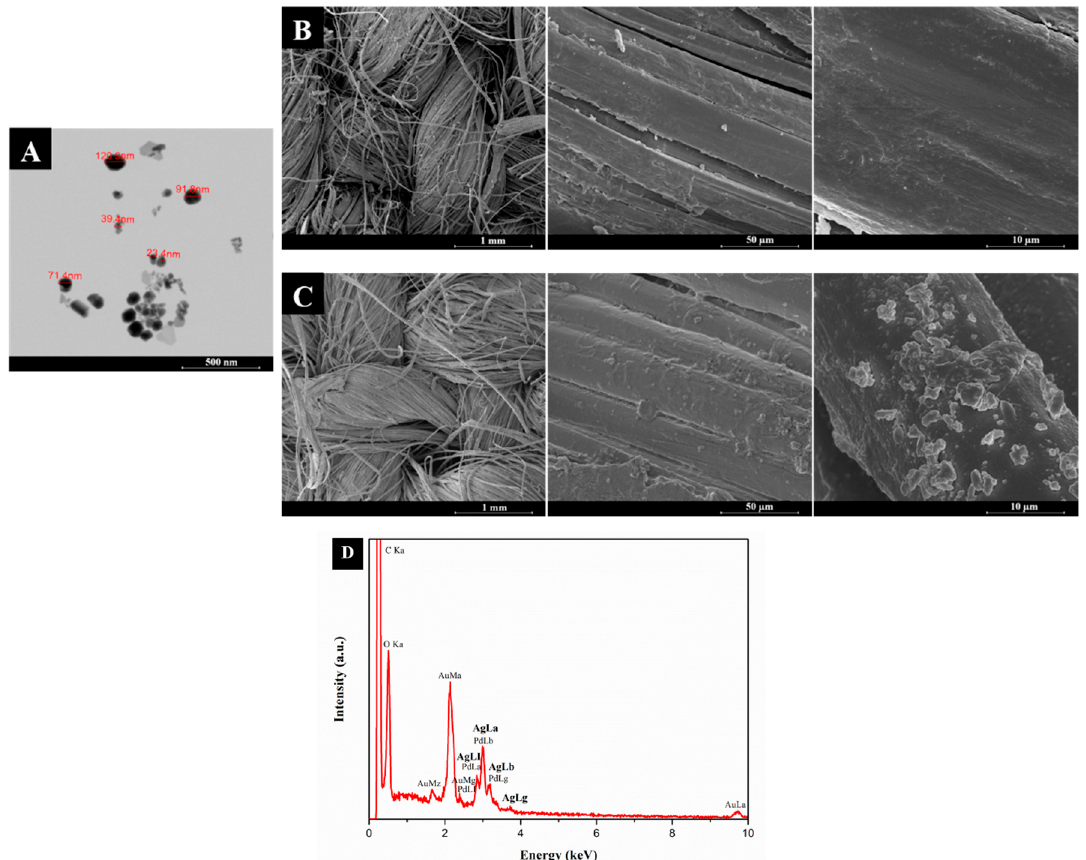
Figure 3. Scanning transmission electron detector (STEM) micrograph of the AgNPs synthesized in polyethylene glycol (PEG) solution with magnifications of 500 nm ( A ). Field Emission Scanning Electron Microscopy (FESEM) images of untreated flax ( B ) and flax + AgNPs ( C ) with magnifications of 1 mm, 50 µm and 10 µm (from the left to the right). The images are in topographic mode. Energy Dispersive Spectroscopy (EDS) spectrum of flax fabric treated with AgNPs ( D ).